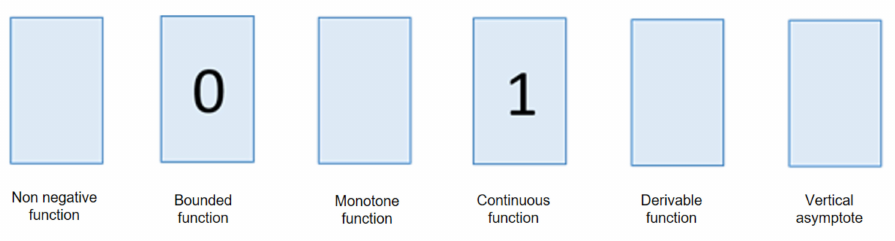
Figure 3. Binary vector that is updated each moment with the known